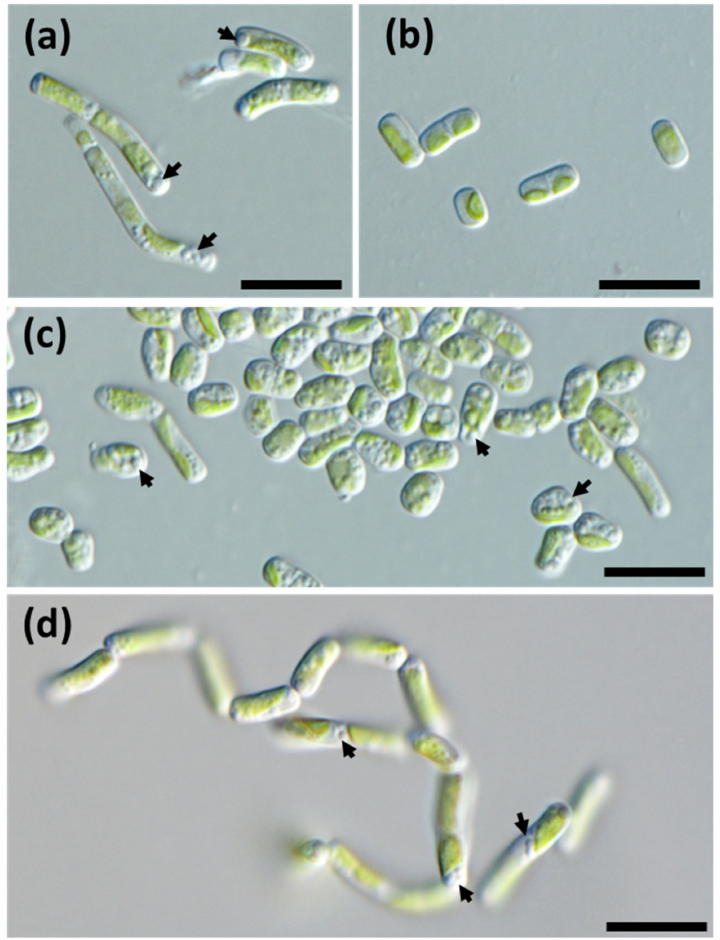
Figure 2. Morphological variability observed in Diplosphaera elongata sp. nov. by DIC microscopy: ( a ) elongated cells growing in liquid 3N-BBM + GC at 18 ◦ C; ( b ) short-cylindrical cells in solid BBM at 18 ◦ C; ( c ) pear-shaped cells in solid 3N-BBM + GC at 18 ◦ C; ( d ) filament in liquid 3N-BBM + GC at 8 ◦ C. Arrows indicate oil vesicles. Scalebars: 10 µ m. Reference strain: ASUV